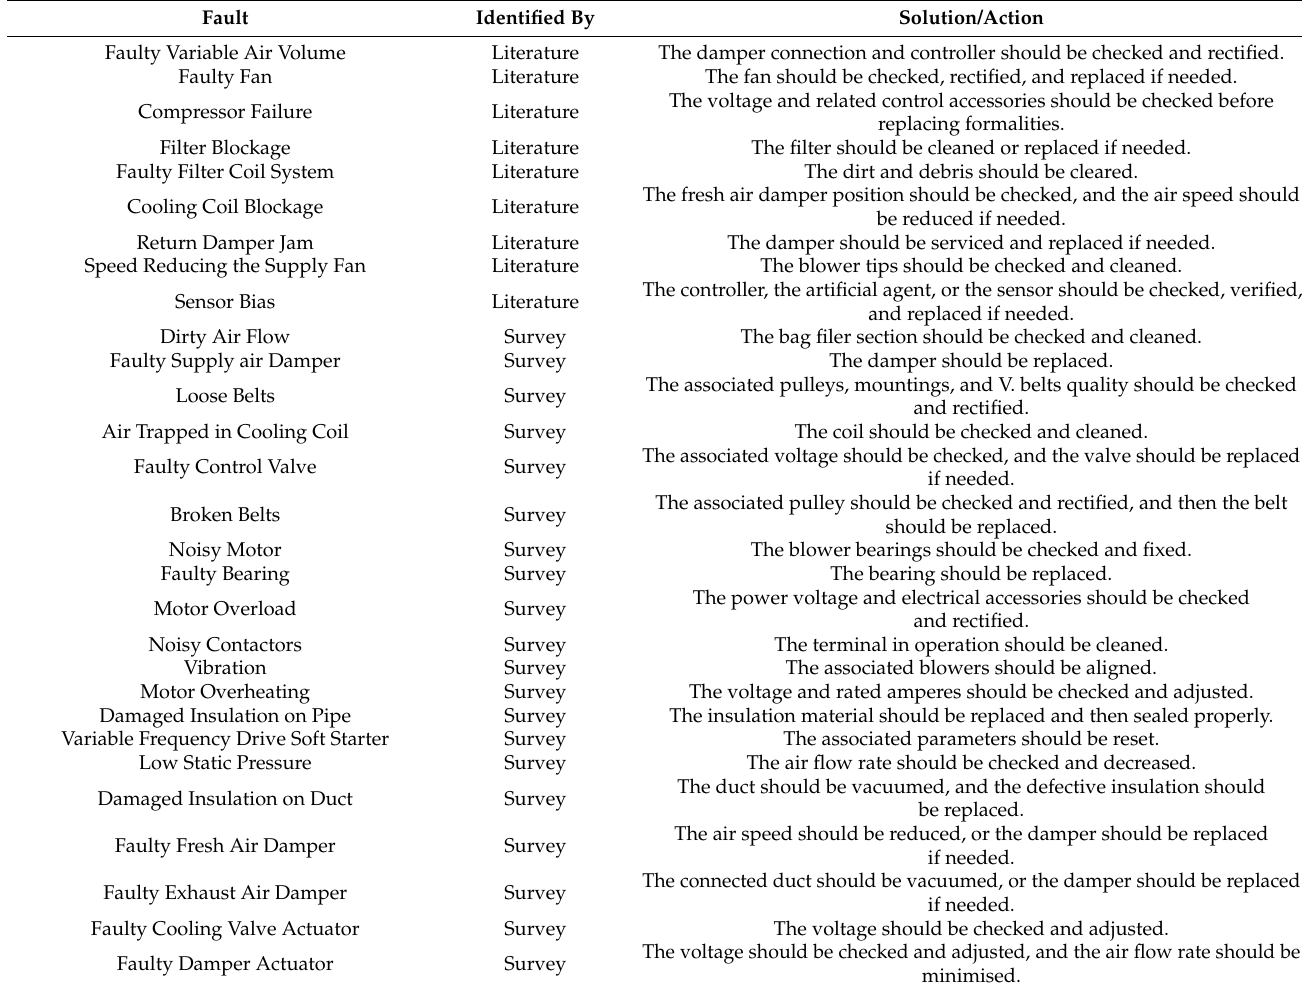
Table 7. Terminal units faults and